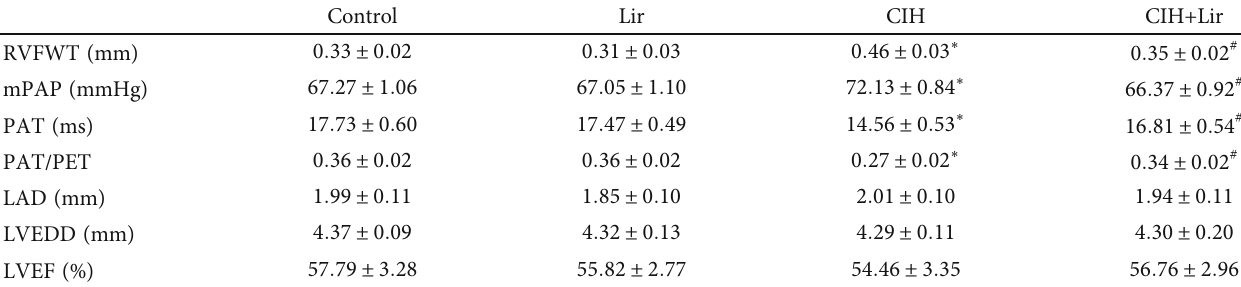
Figure 2: Echocardiography. (a) RV free wall thickness (RVFWT) measured by echocardiography from the parasternal short-axis view at the midpapillary level of the left ventricle. (b) Mean pulmonary artery pressure (mPAP), pulmonary acceleration time (PAT), and PAT/ pulmonary ejection time (PET) ratios measured from pulmonary out fl ow PW Doppler tracings. (c) Representative parasternal long-axis views; M: mode views. Table 2: Echocardiography parameters ( n = 6